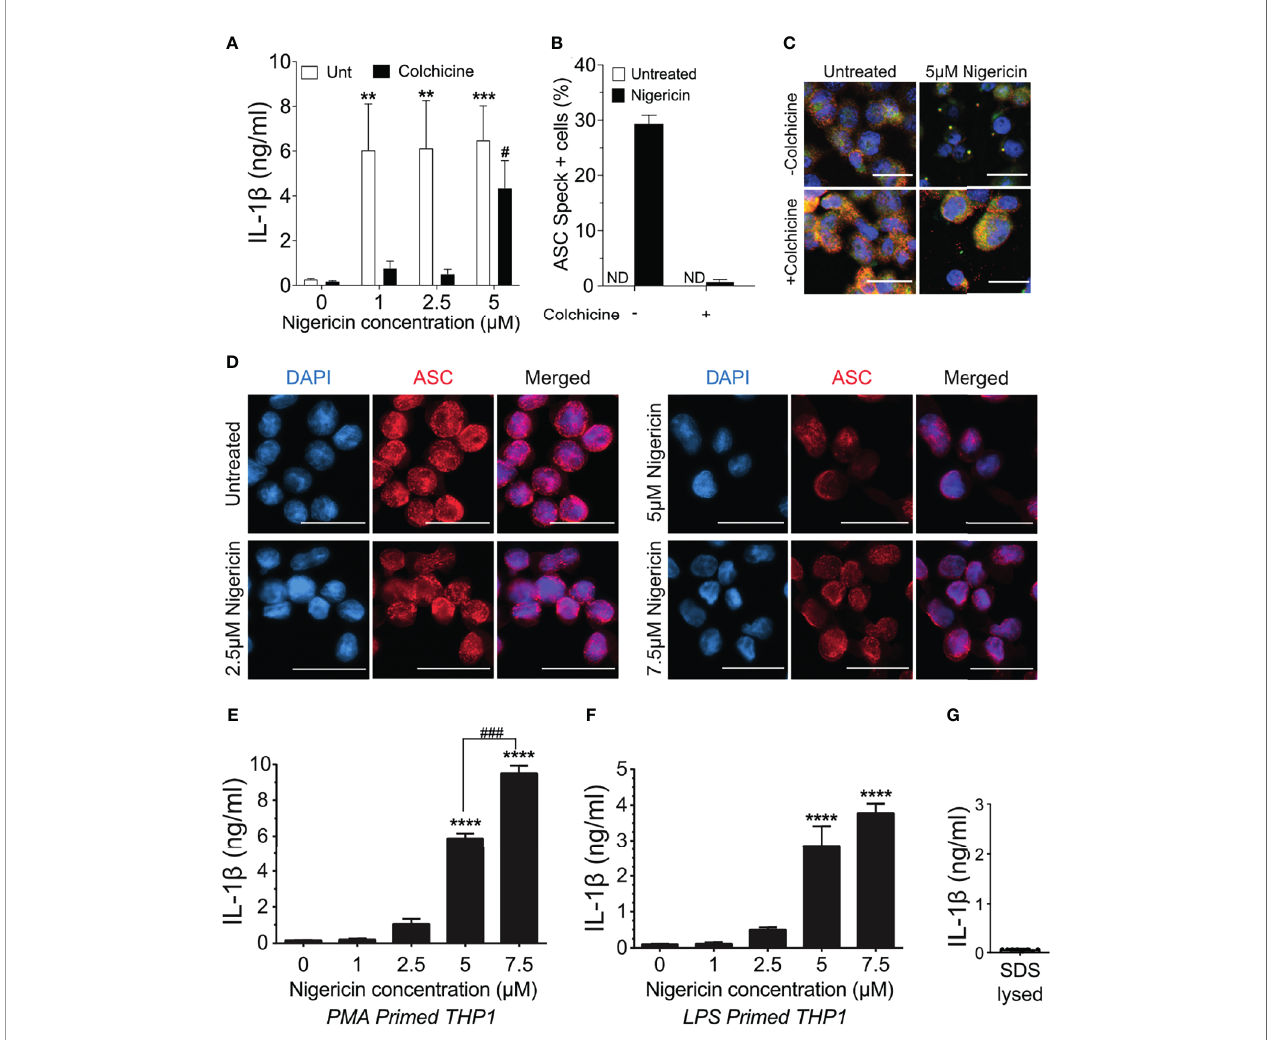
FIGURE 1 | Higher doses of nigericin induce IL-1 b release in the absence of specks. (A) THP-1 cells were treated with 100 nM phorbol 12-myristate 13-acetate (PMA) for 72 h and treated with 5 m M colchicine for 1 h followed by stimulation with different doses of nigericin for 2 h Culture supernatant was used for IL-1 b ELISA. (B) THP-1 cells were treated as described in (A) . Following nigericin stimulation, cells were fi xed and stained for NLRP3 and ASC and analyzed for specks by microscopy. A minimum of 600 cells were analyzed per condition and counted for the presence of speck manually. Data represented as mean ± SEM for two independent experiments. N.D., not detected. (C) Representatives micrographs for data shown in (B) . Cells were stained for NLRP3 (red), ASC (green), and DAPI (blue). Scale bar = 25 nm. Single channel staining shown in Figure S3 . (D) THP-1 cells were primed with 100 nM PMA for 72 h and treated with 5 m M colchicine for 1 h followed by stimulation with nigericin at the indicated concentrations for 2 h. Cells were stained for ASC (red) and DAPI (blue). Scale bar = 25 nm. Representative micrographs are shown. (E) THP-1 cells were primed with 100 nM PMA for 72 h and treated with 5 m M colchicine for 1 h followed by stimulation with nigericin at the indicated concentrations for 2 h. Culture supernatant was used for IL-1 b ELISA. (F) THP-1 cells were treated with 100 ng/ml of LPS for 3 – 4 h and treated with 5 m M colchicine for 1 h followed by stimulation with nigericin at the indicated concentrations for 2 h. Culture supernatant was used for IL-1 b ELISA. (G) THP-1 cells were stimulated with PMA as in (E) and lysed with 0.09% Triton X-100. IL-1 b lysates were diluted 1:5 in assay buffer and measured by ELISA. Data represented as mean ± SEM for a minimum of three independent experiments, unless otherwise mentioned. ** p < 0.01, *** p < 0.001, **** p < 0.0001 for comparison with respective untreated controls; two-way ANOVA followed by Dunnett ’ s (A) multiple comparison tests. # p < 0.05, ### p < 0.001 Student ’ s t -test for comparison between colchicine-treated cells stimulated with or without 5 m M